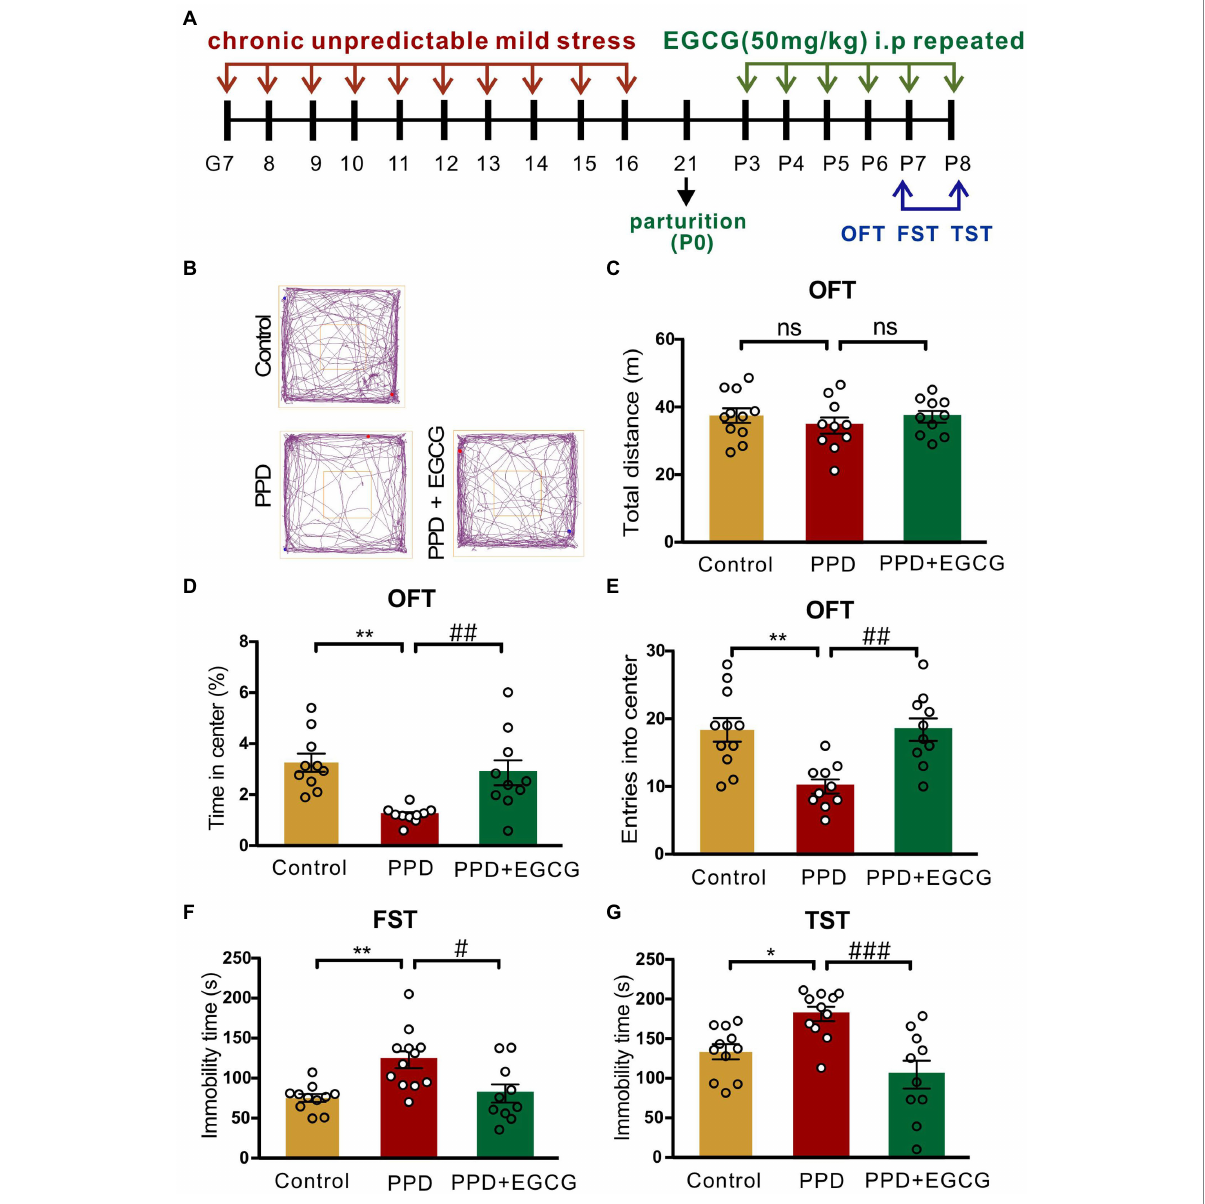
FIGURE 5 EGCG alleviated the postpartum anxiety and depressive-like behaviors of PPD-mice. (A) Experimental diagram showing the timeline of model establishment, drug administration and behavioral tests. (B) The representative movement tracks of each group. (C–E) Histograms showing the total distance traveled, time spent in the center, and number of entries into the center of mice during the OFT. (F) Histogram showing the immobility time of mice in the FST. (G) Histogram showing the immobility time of mice in the TST. Data were mean ± SEM. White circles represent individual data points. * p < 0.05; ** p < 0.01 vs. Con; # p < 0.05; ## p < 0.01, ### p < 0.001 vs. PPD; ns, not